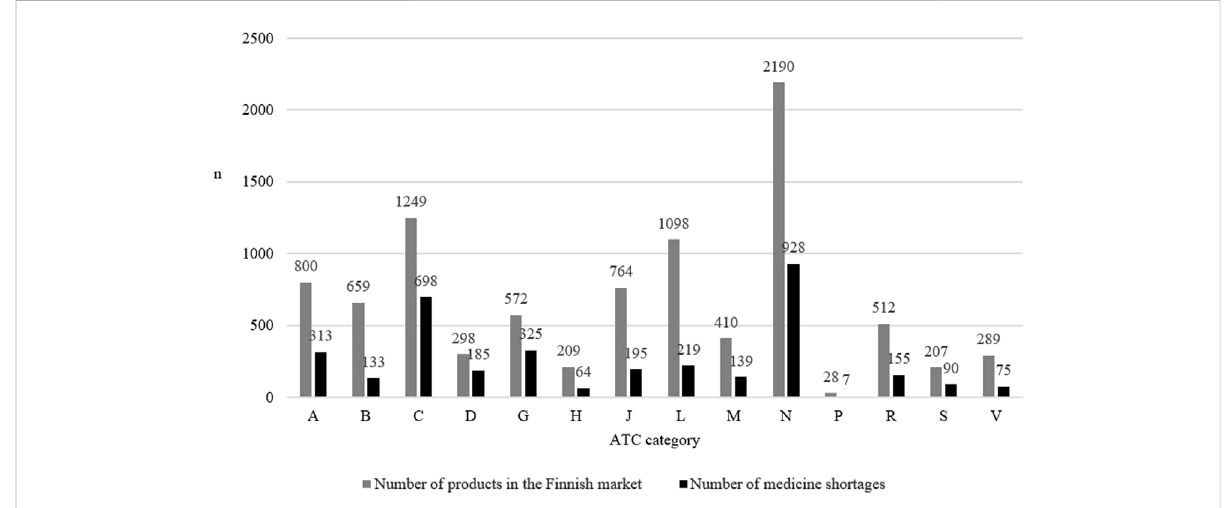
FIGURE 1 The number of products on the Finnish market in 2022 according to the Anatomic Therapeutic Chemical (ATC) category and the number of medicine shortages in Finland ( N = 3,526) in each category from 2017 to 2019.